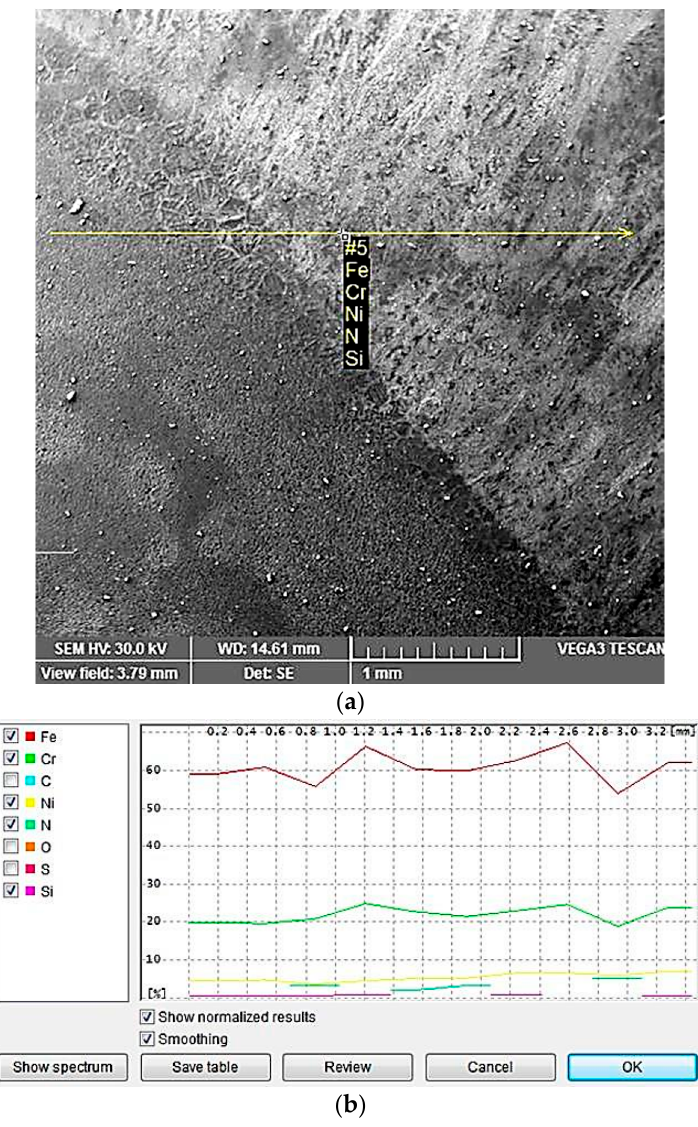
Figure 11. Examination of the median zone in the deposited layer with E l = 15 kJ/cm; and ( a ) SEM image; ( b ) line scans showing the compositional variation for the region indicated in ( a ).